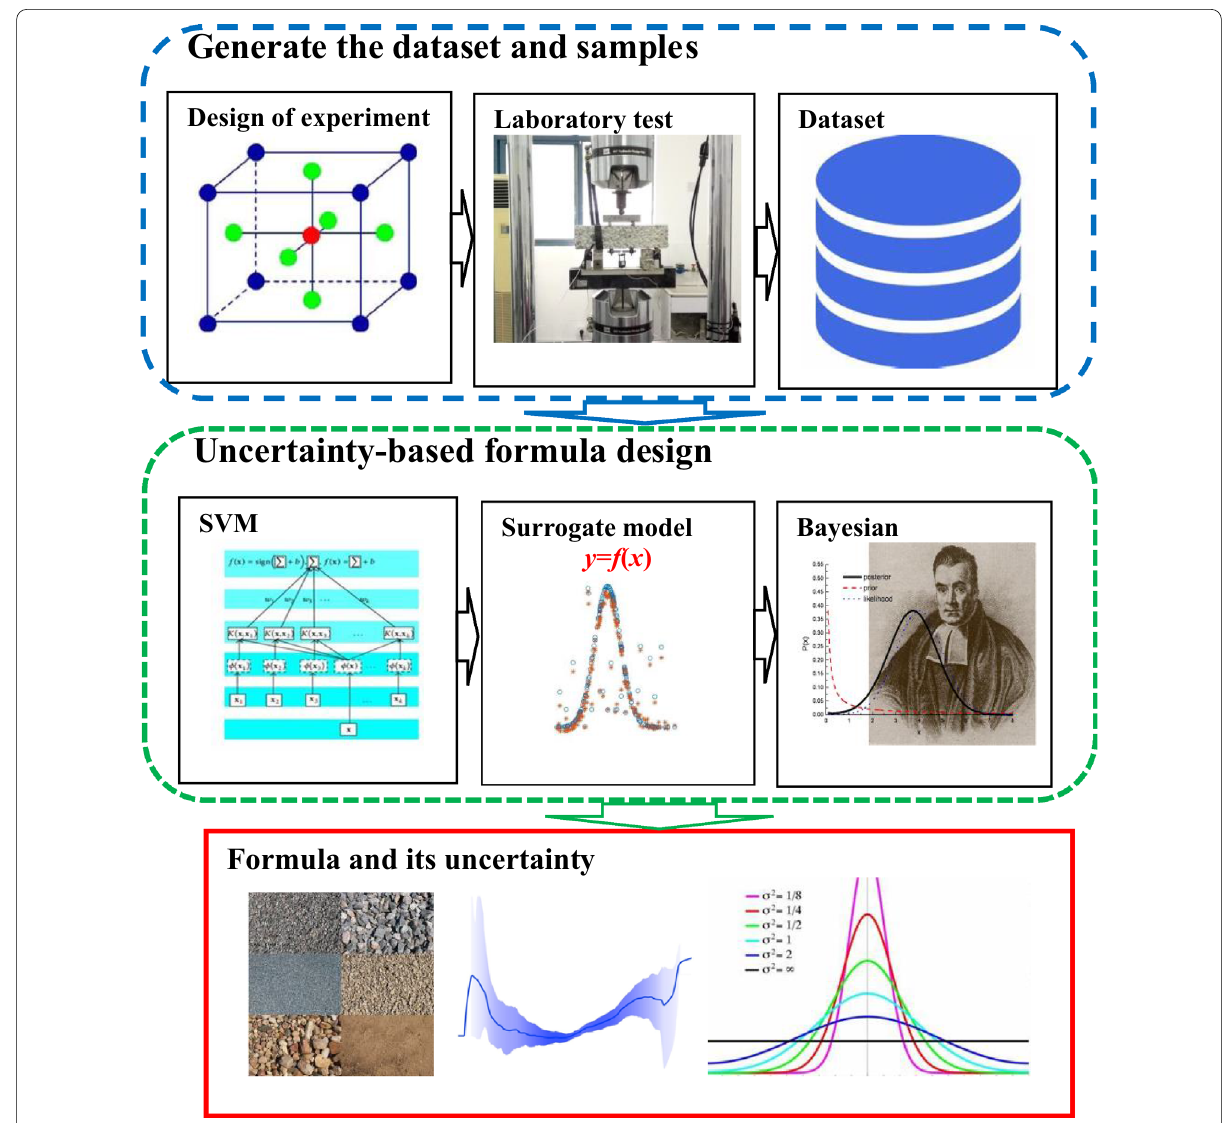
Fig. 1 Framework of the developed method